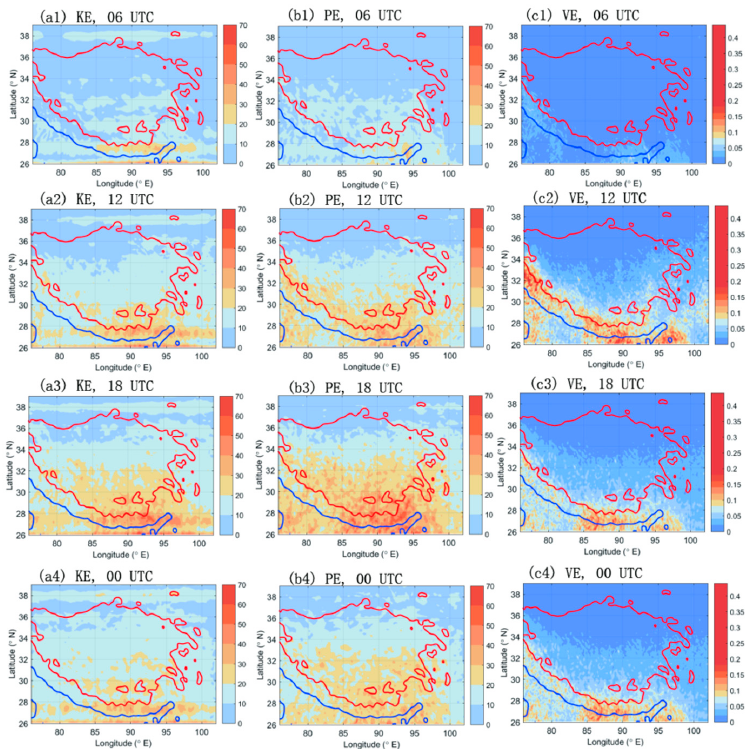
Figure 9. Time-averaged ( a1 )–( a4 ) KE (unit: J/kg, shading, c.i. = 10), ( b1 )–( b4 ) PE (unit: J/kg, shading, c.i. = 10), and ( c1 )–( c4 ) VE (unit: J/kg, shading, c.i. = 0.02; due to the large amplitude oscillation at different times, same red color uses for VE value greater than 0.2) at ( a1 )–( c1 ) 06 UTC, ( a2 )–( c2 ) 12 UTC, ( a3 )–( c3 ) 18 UTC, and ( a4 )–( c4 ) 00 UTC at 30 hPa.